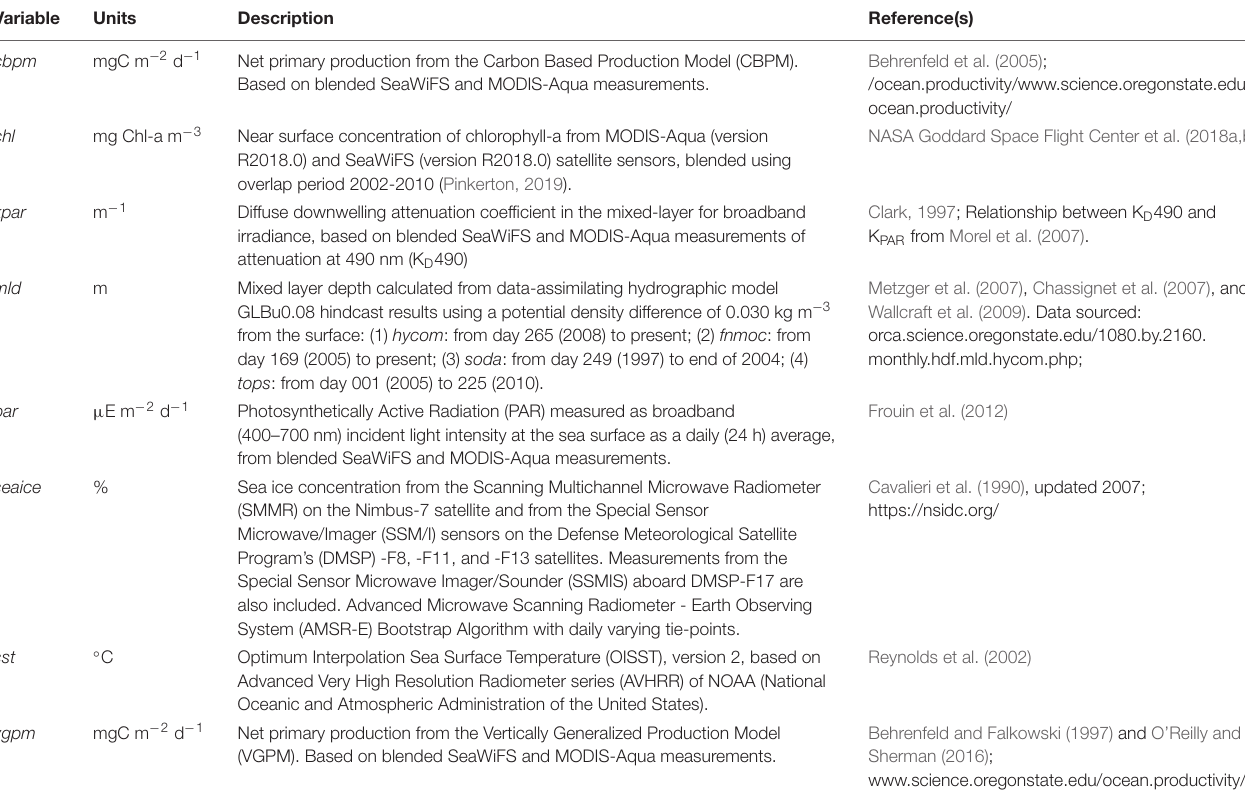
TABLE 1 | Environmental data used in analysis (in alphabetical order).